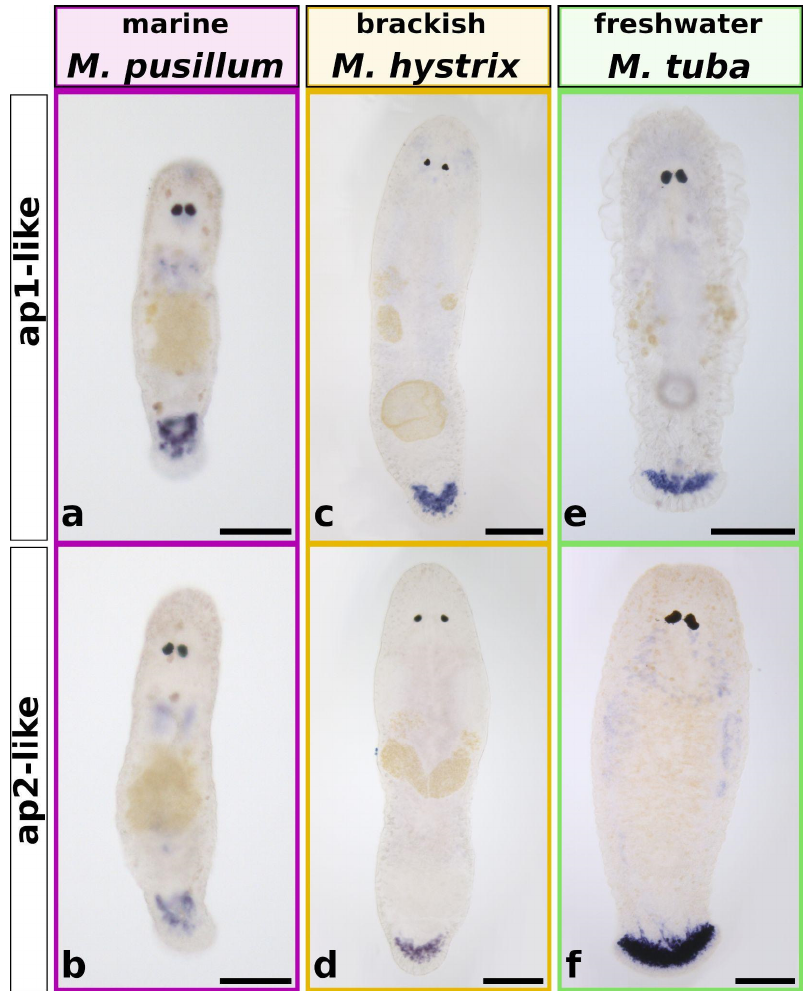
Figure 5. Whole-mount in situ hybridisation of ap1- and ap2-like genes in three Macrostomum species. ap1 and ap2 expression in the marine M. pusillum ( a , b ), in the brackish water M. hystrix ( c , d ), and in the freshwater M. tuba ( e , f ). Marine species outlined in pink, brackish species outlined in yellow, freshwater species outlined in green. Scale bars: 50 µm in ( a , b ); 100 µm in ( c – f ).